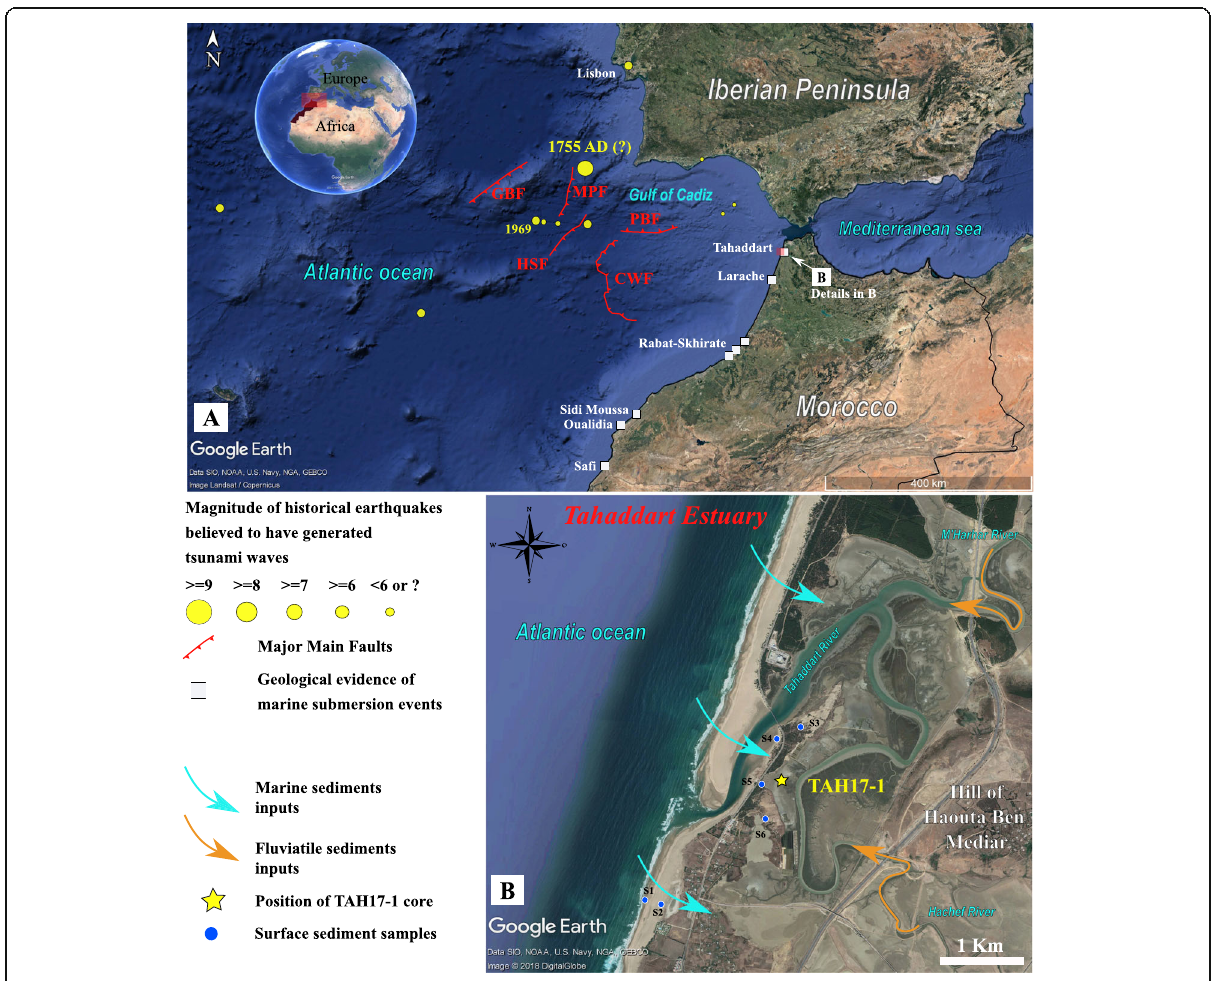
Fig. 1 a Google Earth image showing the Gulf of Cadiz. Historical data of seismic events generating (or believed to have generated) tsunami waves are from NOAA ’ s National Centers for Environmental Information (NCEI 2020). They are presented as yellow dots with magnitude ranging between 6 and 9. Potential tsunamigenic faults (red traces) in the Gulf of Cadiz are simplified from Omira et al. (2009). White squares illustrate onshore geological evidences of marine submersion events along the Atlantic coast of